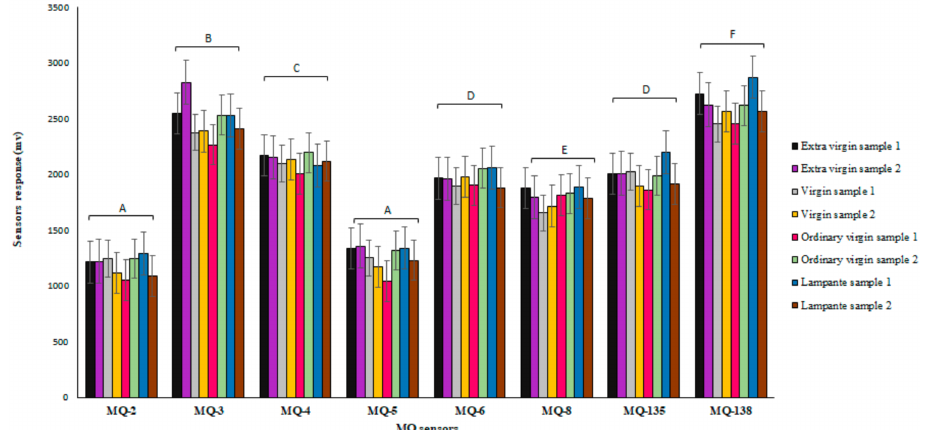
Figure 3. Responses the sensors for two samples according to the different groups of olive oil quality. Least significant differences (LSD; p < 0.05) test showed that there were five groups of sensors according to their signal’s significance: A, MQ-2 and MQ-5; B, MQ-3; C, MQ-4; D, MQ-6 and MQ-135; E, MQ-8; and F,